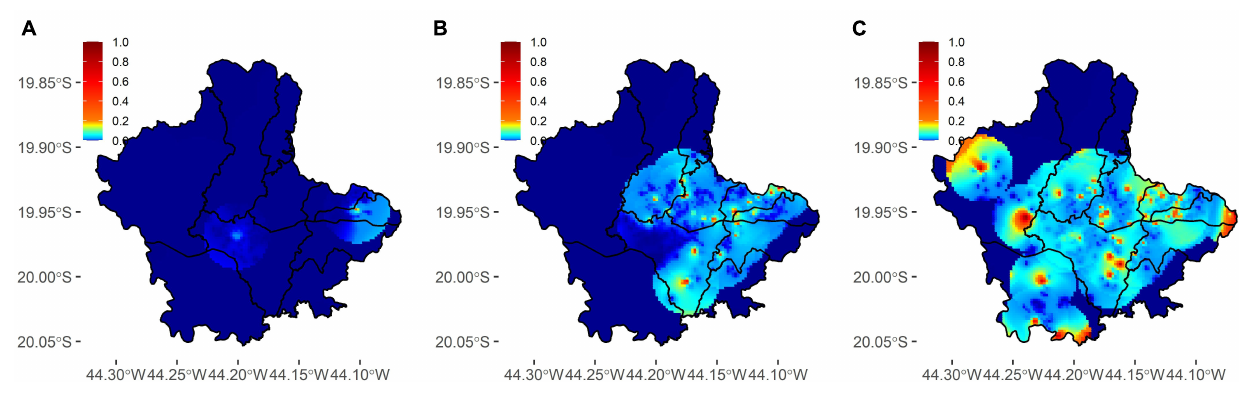
FIGURE 3 | Spatial distribution of active infections across three surveys in Betim. (A–C) Dispersion of positive molecular tests across each survey. In the third survey (C) , most populated areas of the city already had a non-null probability of presenting residents with a positive molecular